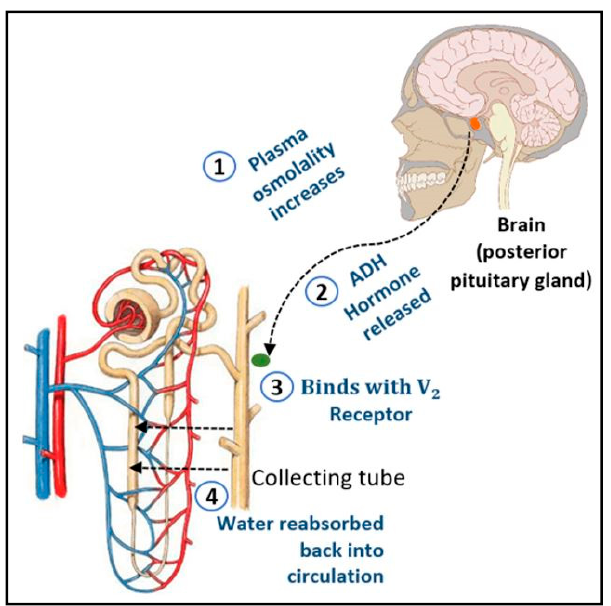
Figure 1. Role of anti-diuretic hormone (ADH) in maintaining plasma osmolality of human body.